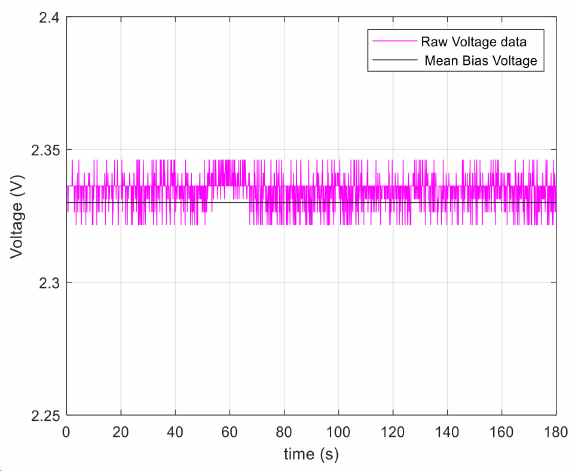
Figure 10. The bias voltage (output at v w =